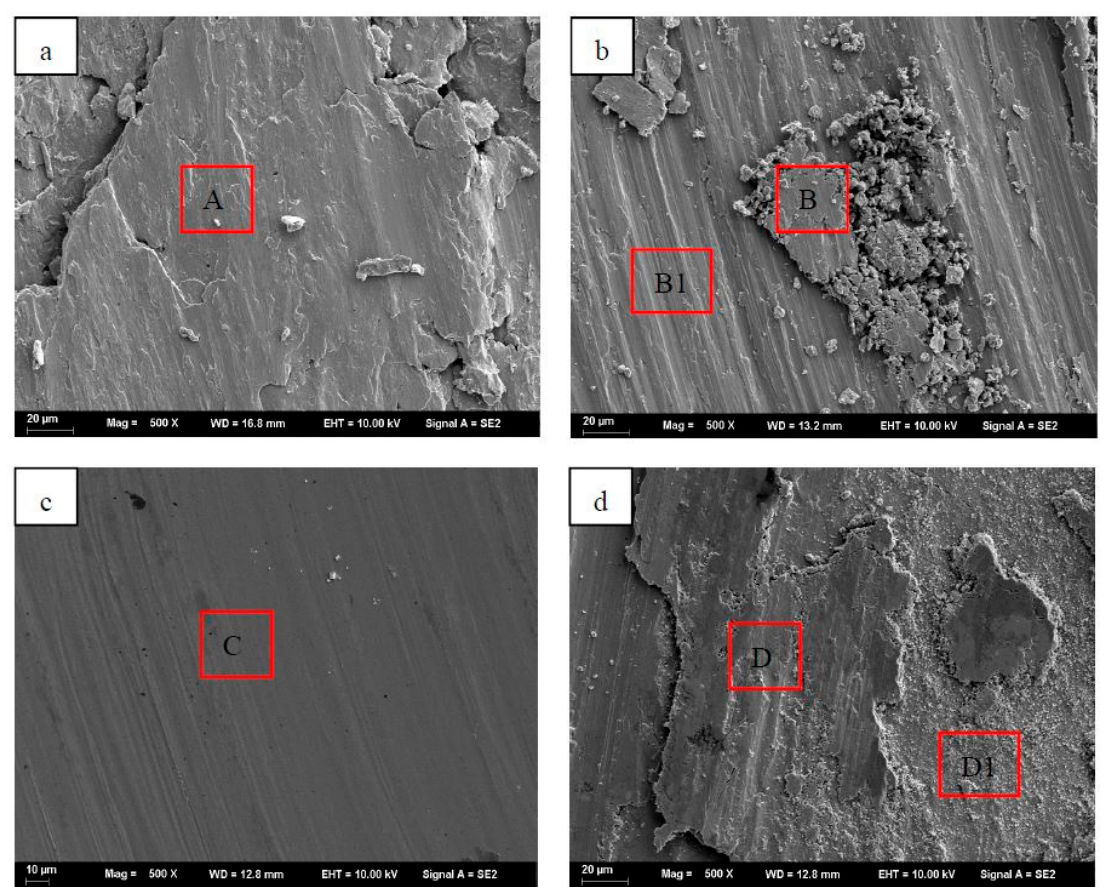
Figure 6. SEM image of worn surfaces of ( a ) CNE0, ( b ) CNE5, ( c ) CNE15, and ( d ) CN15.